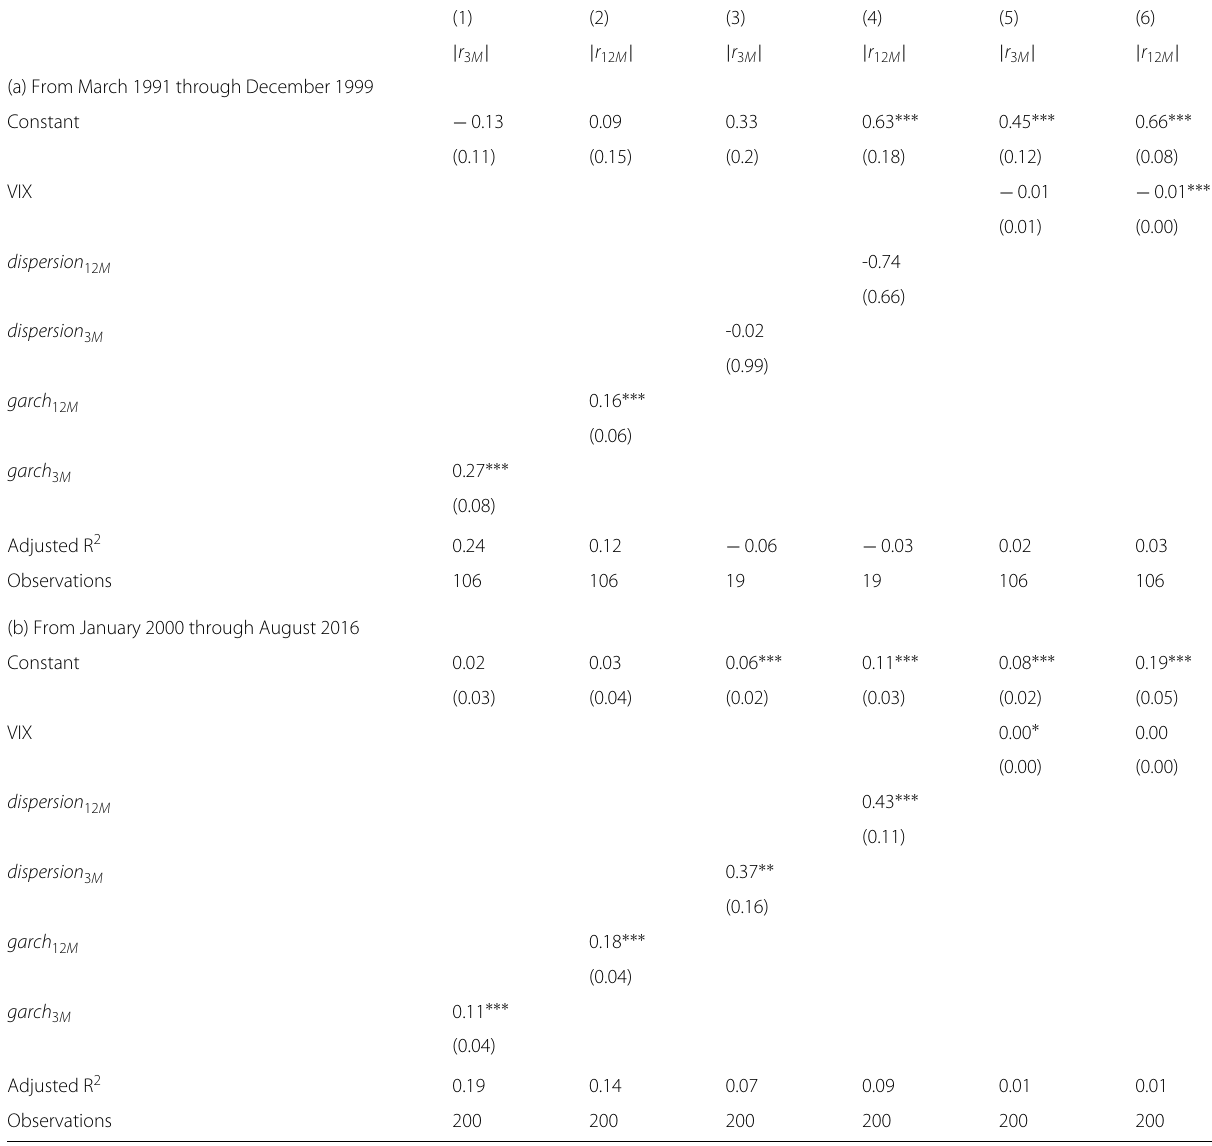
Table 9 Uncertainty and the size of the absolute term premium by